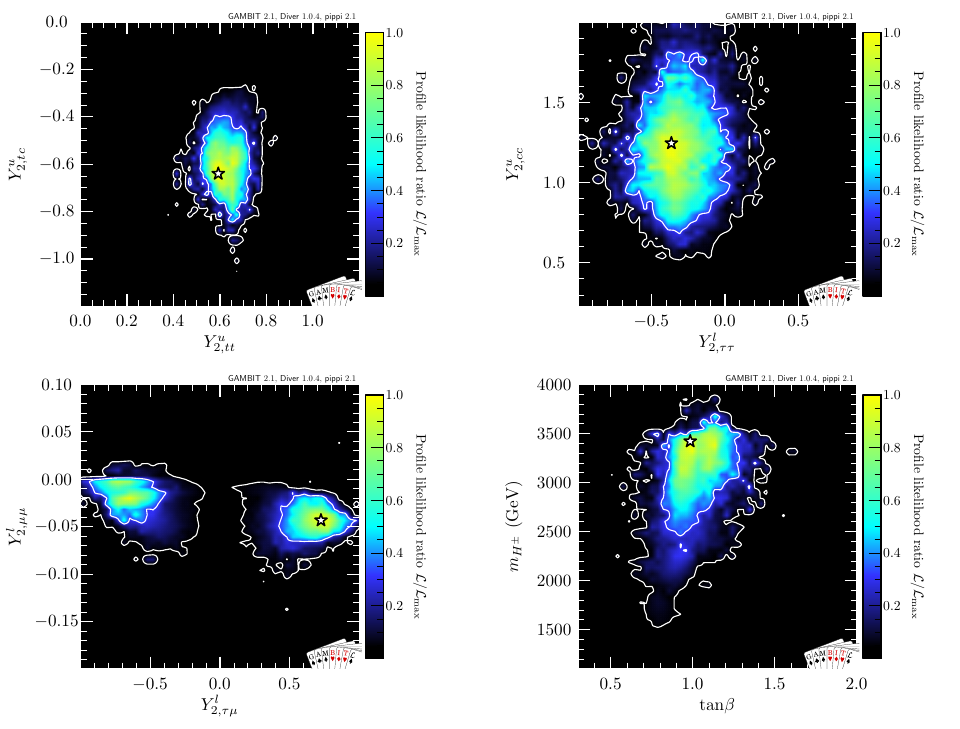
Figure 8 . Profile likelihood ratios L / L max for different 2D plots of the parameter space for Y u [ − 2 , 0]